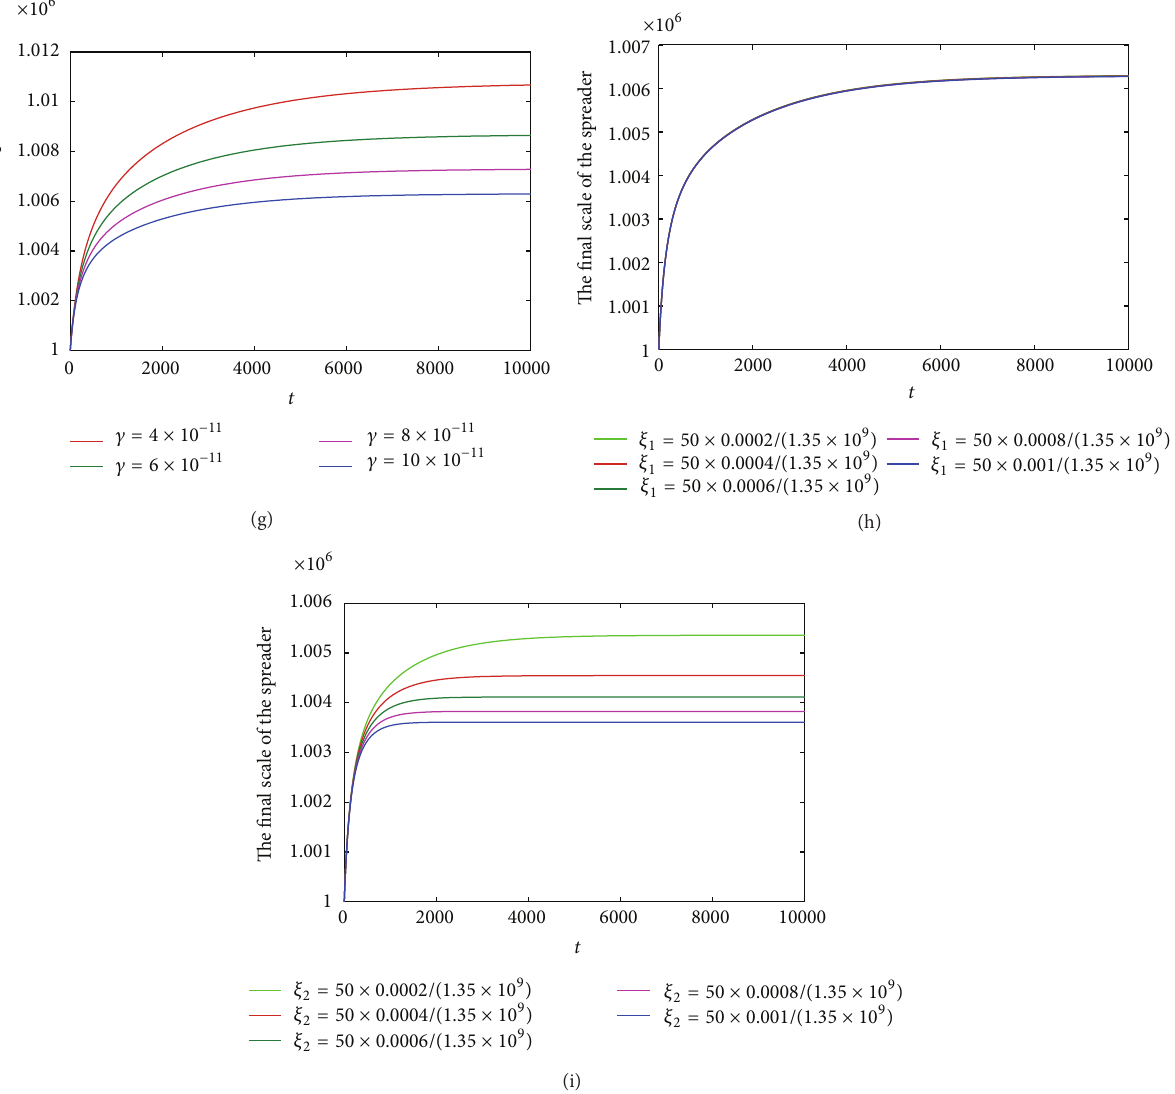
Figure 3: The sensitivity of the final scale in terms of parameters. (a) 𝜃 . (b) 𝜂 . (c) 𝜇 . (d) 𝑏 . (e) 𝛽 . (f) 𝛼 . (g) 𝛾 . (h) 𝜉 1 . (i) 𝜉 2 .